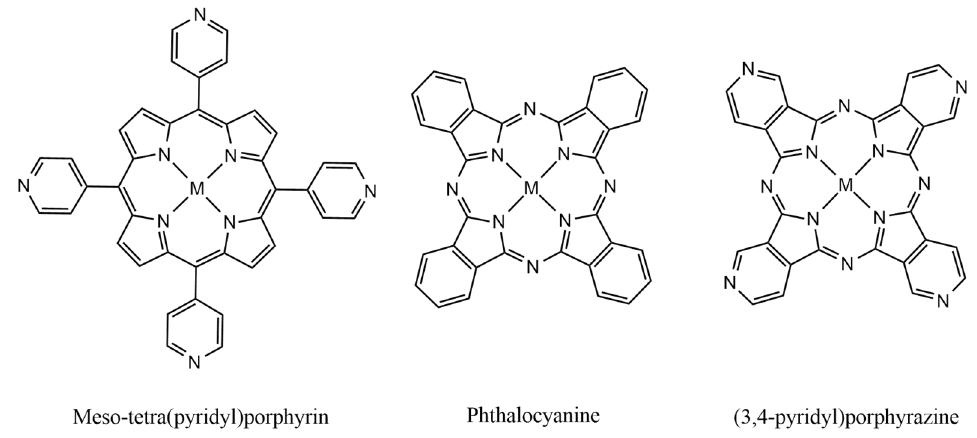
Figure 1. Chemical structures of some MNC metal–organic materials.